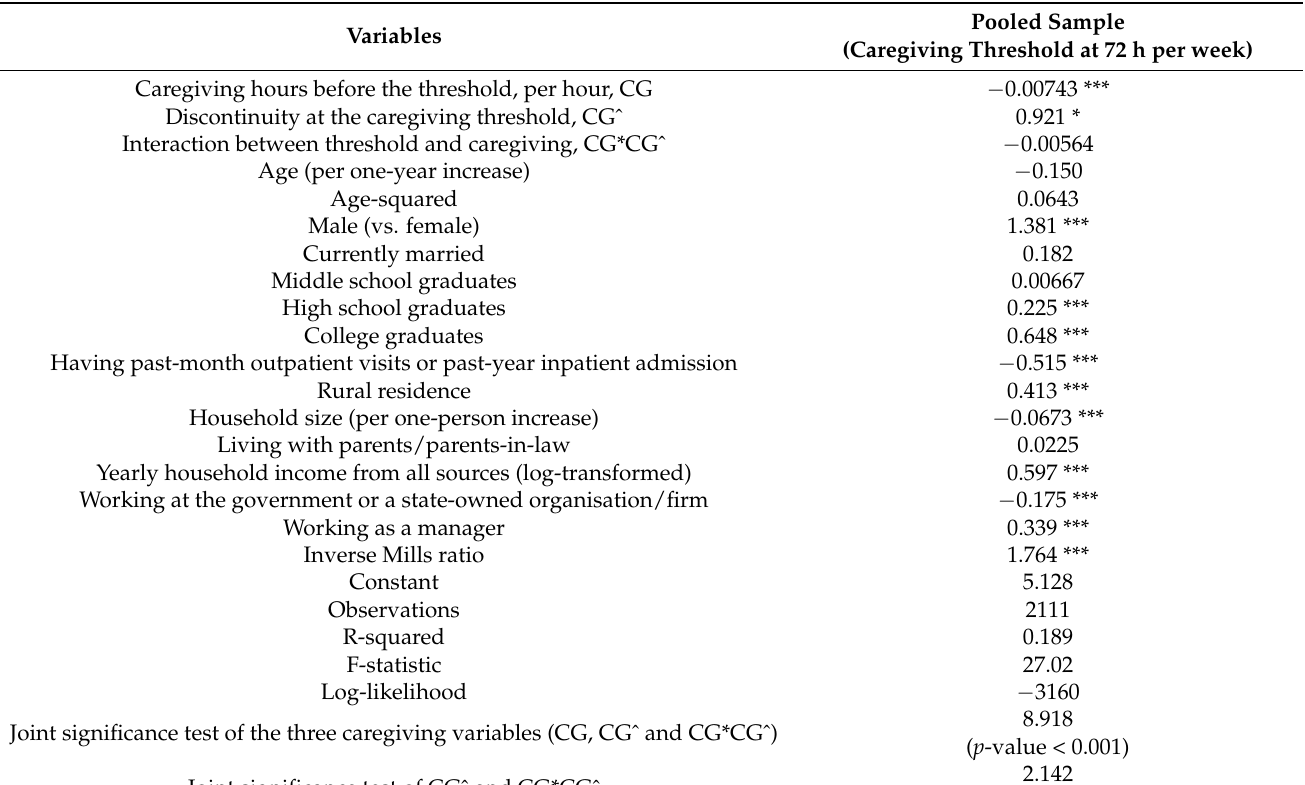
Table A3. Results of the Heckman selection model predicting log-transformed monthly employment income using the pooled sample of women and men.